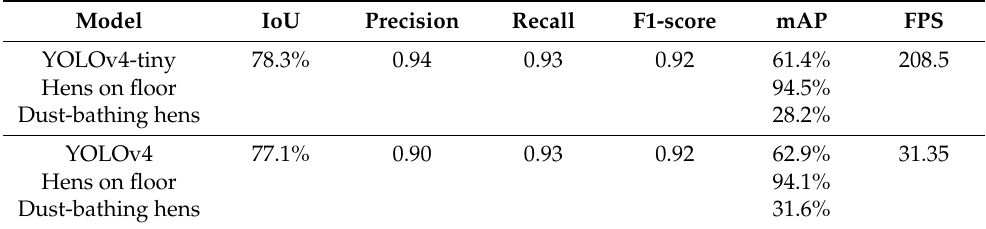
Table 2. Metrics of the two models on the validation dataset (average precision for each class) for the classification of hens on the floor and dust-bathing